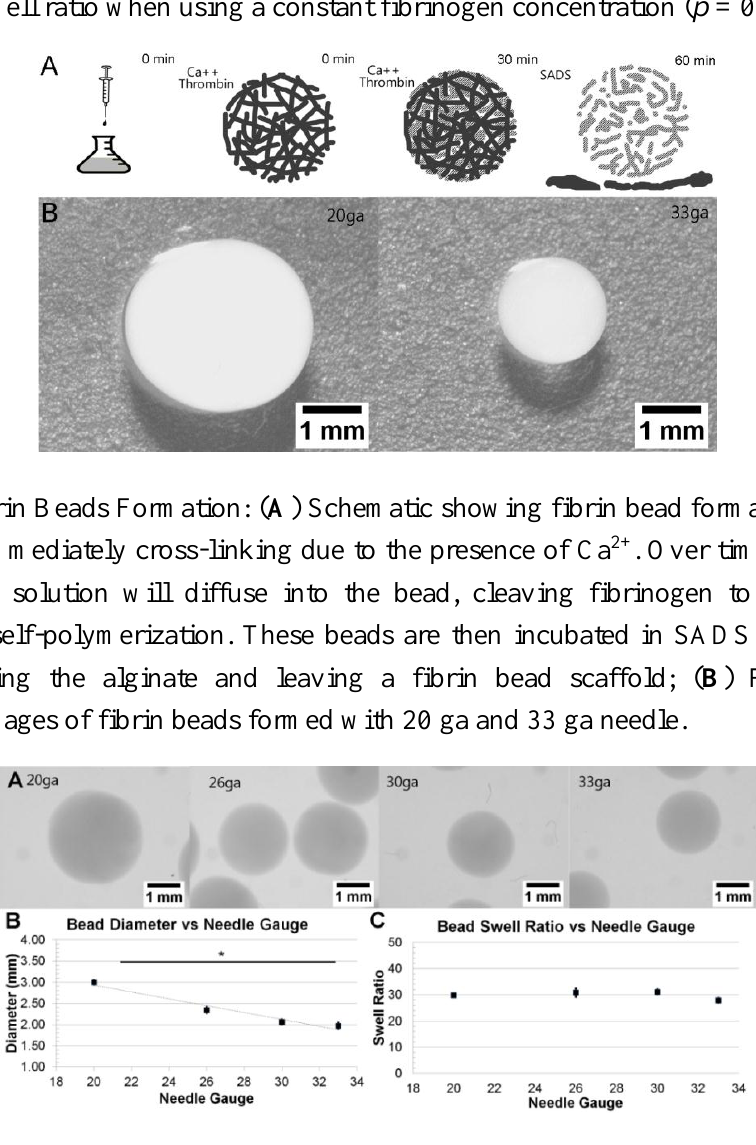
Figure 2. Variation of Bead Diameter with Needle Gauge: ( A ) Representative images of fibrin beads at various gauge needles; ( B ) Graph depicting the dependence of bead diameter on needle gauge ( p < 0.05); ( C ) Graph showing no general relationship between needle gauge and bead swell ratio ( p >